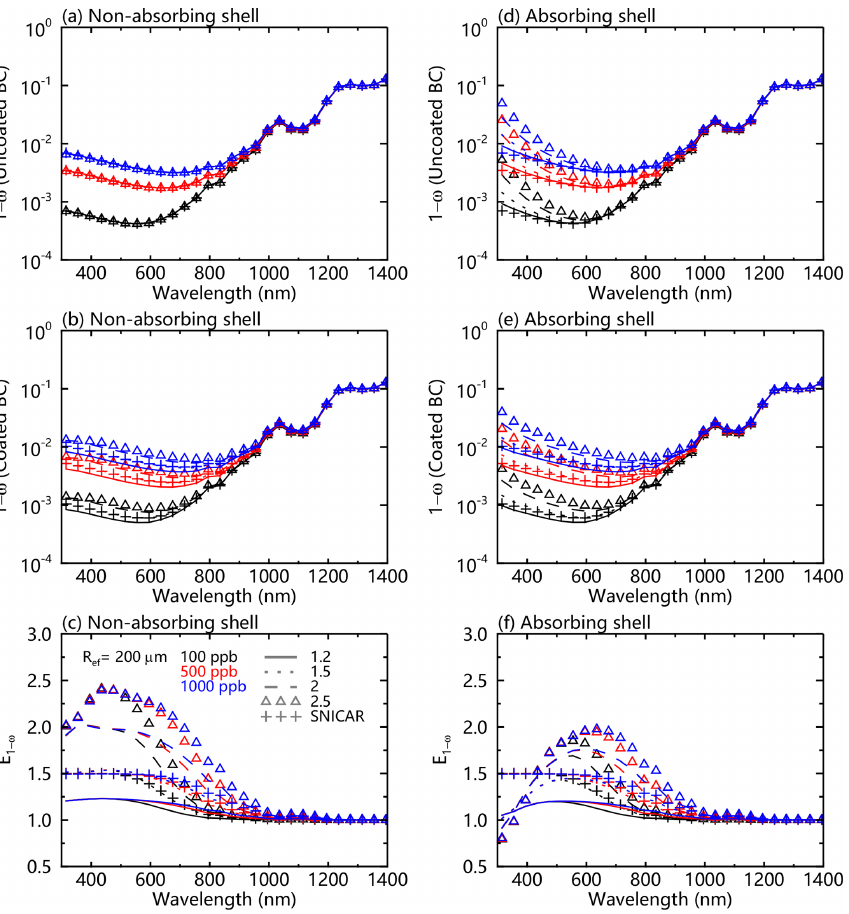
Figure 2. Snow single-scattering co-albedo (1 − ω ) as a function of the wavelength, at different BC concentrations and core / shell ratios for (a) uncoated and (b) coated BC particles under the assumption of a nonabsorbing shell. Panels (d) and (e) are the same as (a) and (b) , respectively, but under the assumption of an absorbing shell. Panel (c) shows the ratios of the snow single-scattering co-albedo ( E 1 − ω ) for coated versus uncoated BC particles under the assumption of a nonabsorbing shell. Panel (f) is the same as (c) but under the assumption of an absorbing shell. The snow grain radius was assumed to be